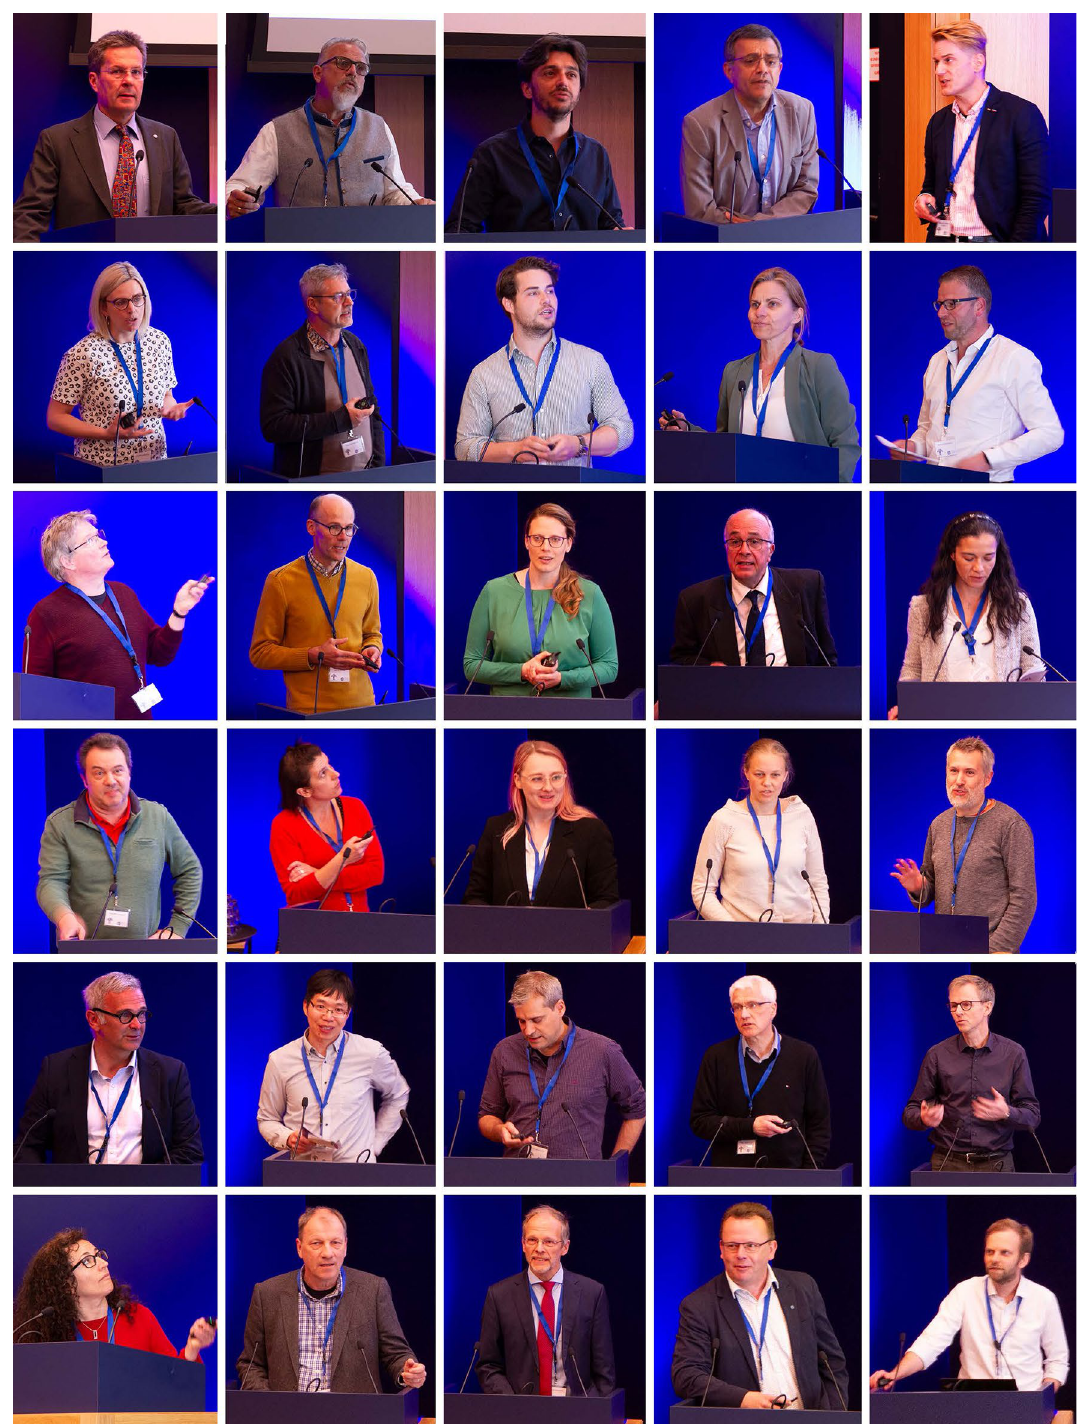
Fig. 11 Rise of the fungi 2022